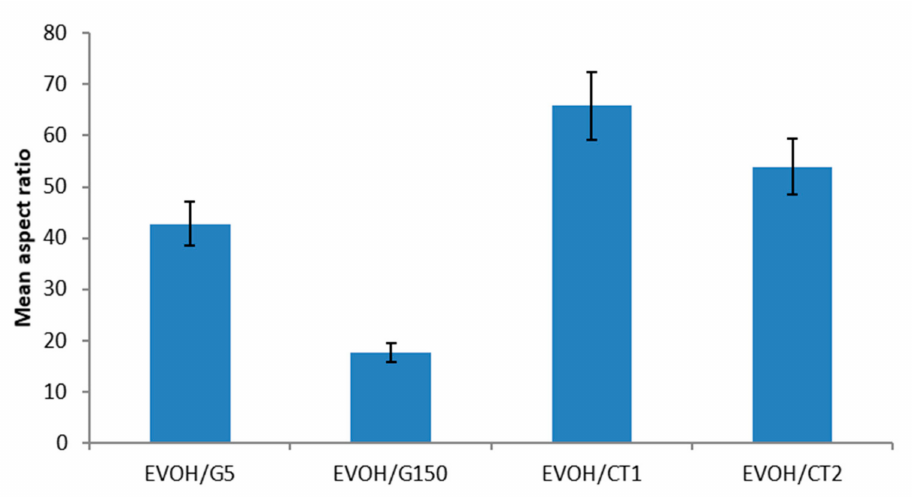
Figure 3. Comparison of the mean average aspect ratio of the filler as a function of the studied